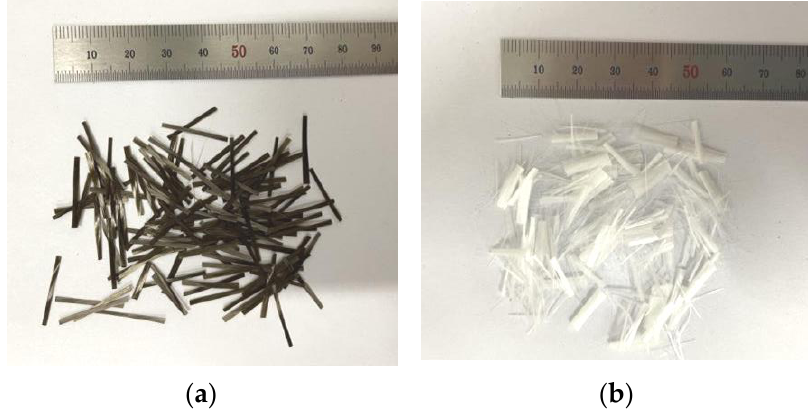
Figure 2. The appearance of the fibers: ( a ) basalt fibers; ( b ) polyvinyl alcohol fibers.